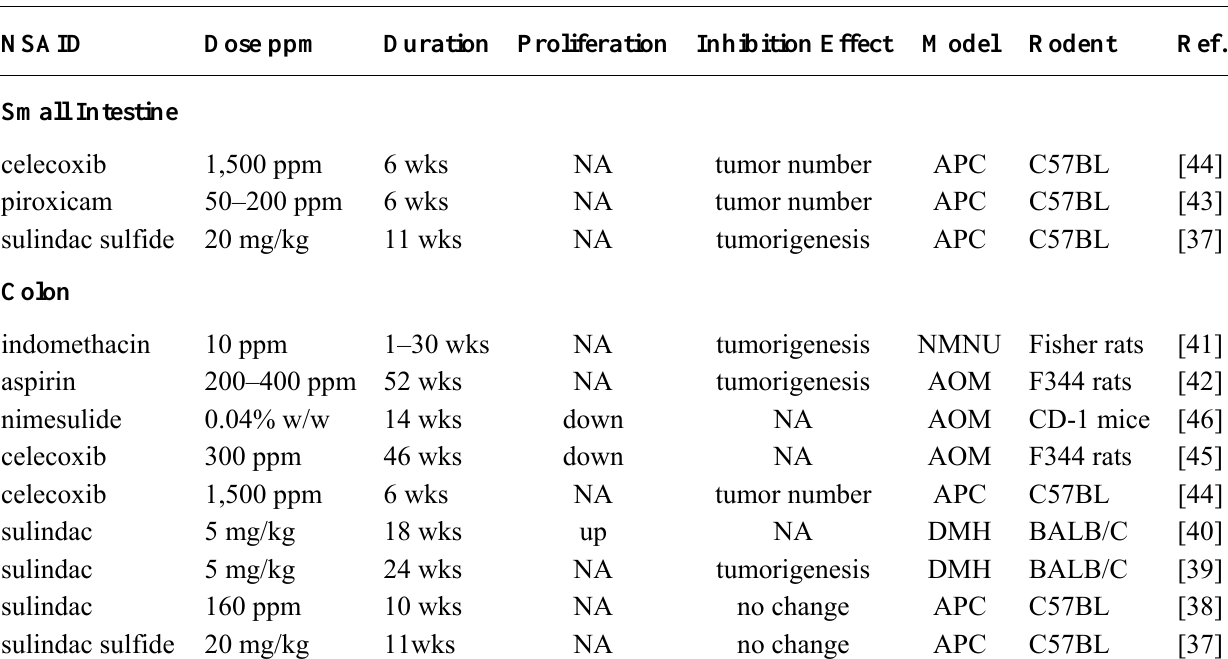
Table 2. The doses of NSAIDs administered in vivo in tumour model experiments and their effect on initiation and progression of carcinogenesis. The duration of treatment is presented and the effect on proliferation is indicated. NMNU = n-methyl-N-nitrosourea, coli, NA = not